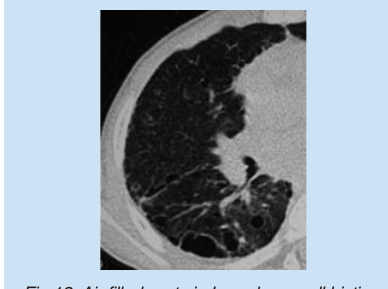
Fig.13. Air-filled cysts in Lagerhans cell histio- cytosis.